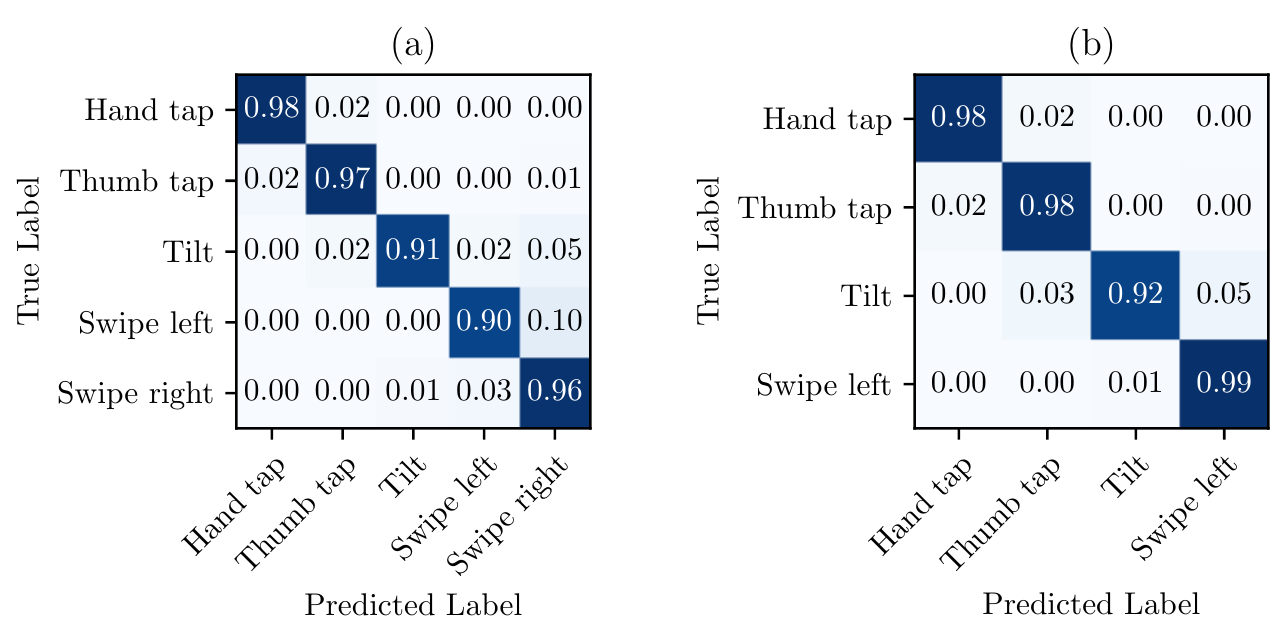
Figure 6. Normalized confusion matrices, resulting from the validation of the optimized SVM classifier for ( a ) five different gestures and ( b ) four different gestures.